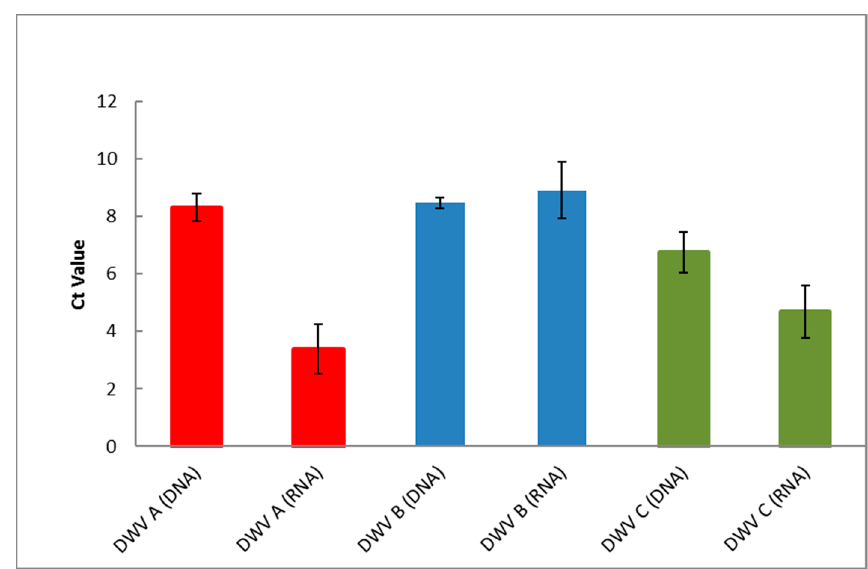
Figure 3. Reproducibility of RT-PCR and PCR assays for each DWV primer set. Bars display the mean C t of the average data calculated from the dilution series. Error bars show the deviation from the mean C t between serial dilutions. DNA from plasmid, RNA refers to cRNA, DNA copy number = 10 9 , RNA copy number = 10 10 .